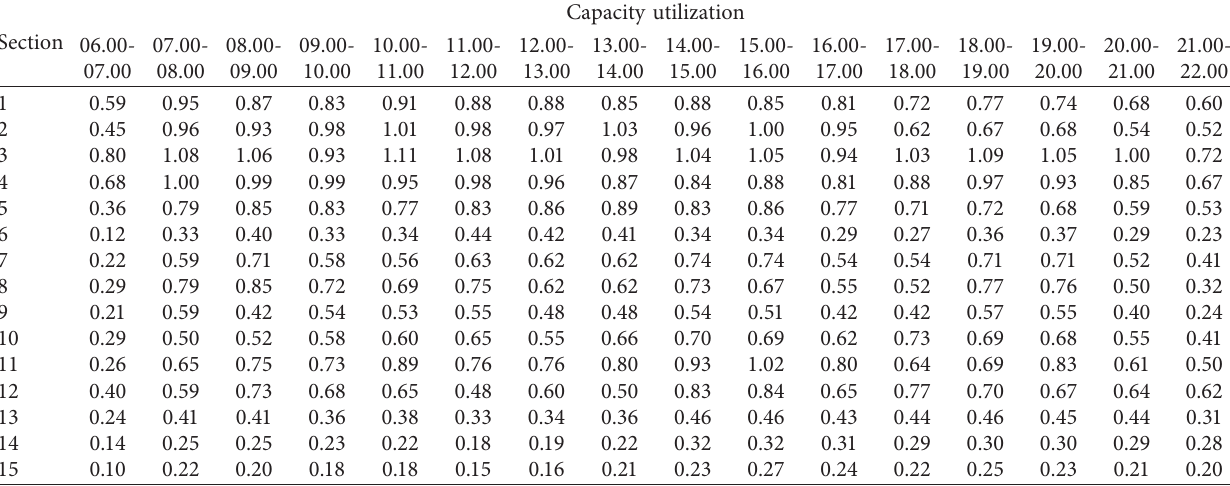
Table 6: Capacity utilization by sections and hours in a day for direction B.